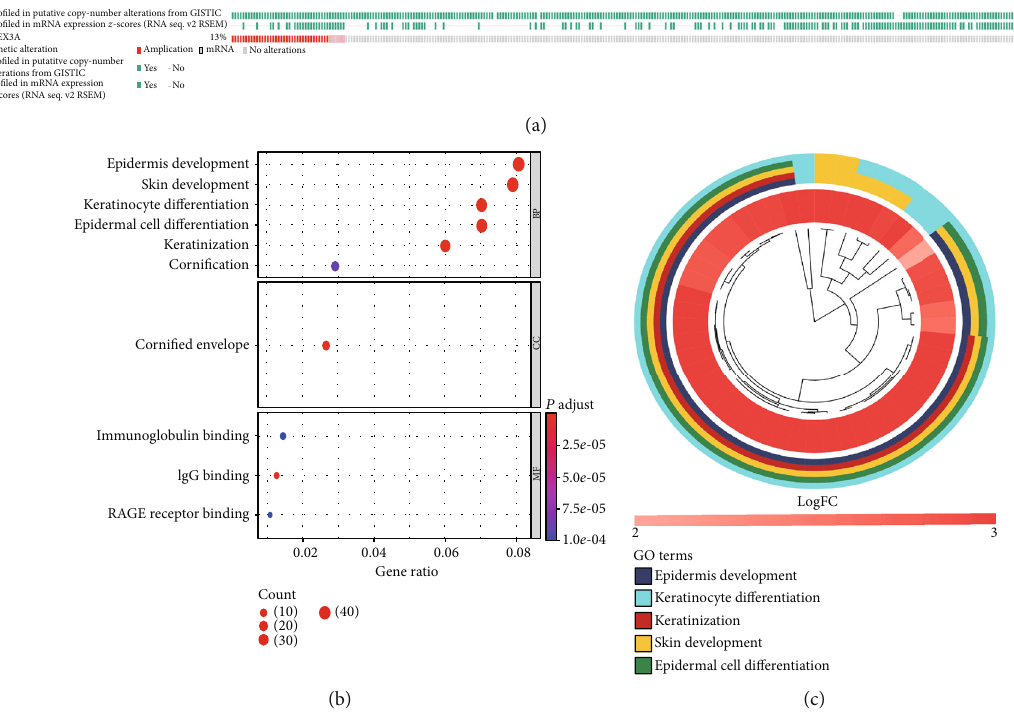
Figure 5: Analyses of genetic variations of MEX3A in OC (cBioPortal). (a) OncoPrint visual summary of variations on MEX3A. The di ff erent types of genetic alterations are represented by di ff erent colors. (b, c) Functional enrichment analyses of genes coexpressed with